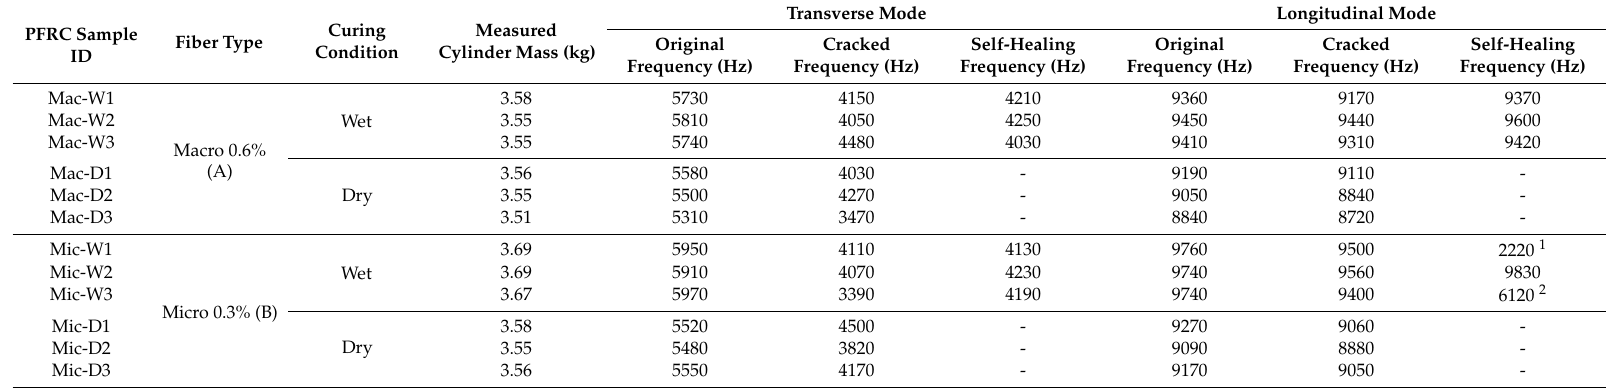
Table 7. Transverse and longitudinal resonant frequency of PFRC